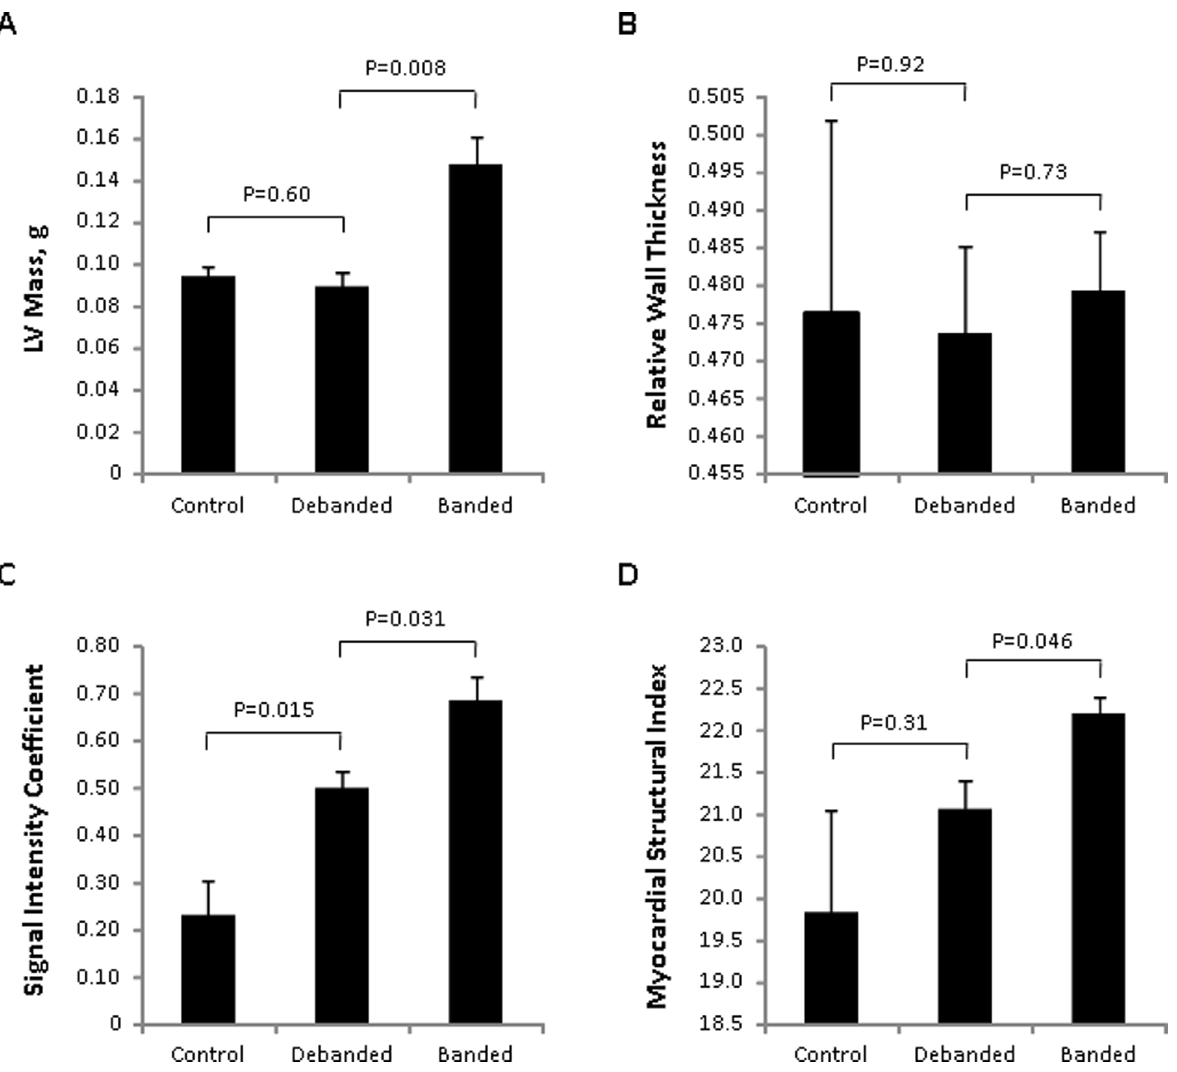
Figure 2. Mean ( ± standard error) values of conventional and advanced echocardiographic measures are displayed for each group of mice. : vehicle control, banded and then debanded mice, and continually banded mice. Conventional echocardiographic measures include left ventricular mass (Panel A) and relative wall thickness (Panel B). Advanced measures include the signal intensity coefficient (Panel C) and myocardial structural index (Panel D). P values are for Kruskal-Wallis tests of difference between independent groups.